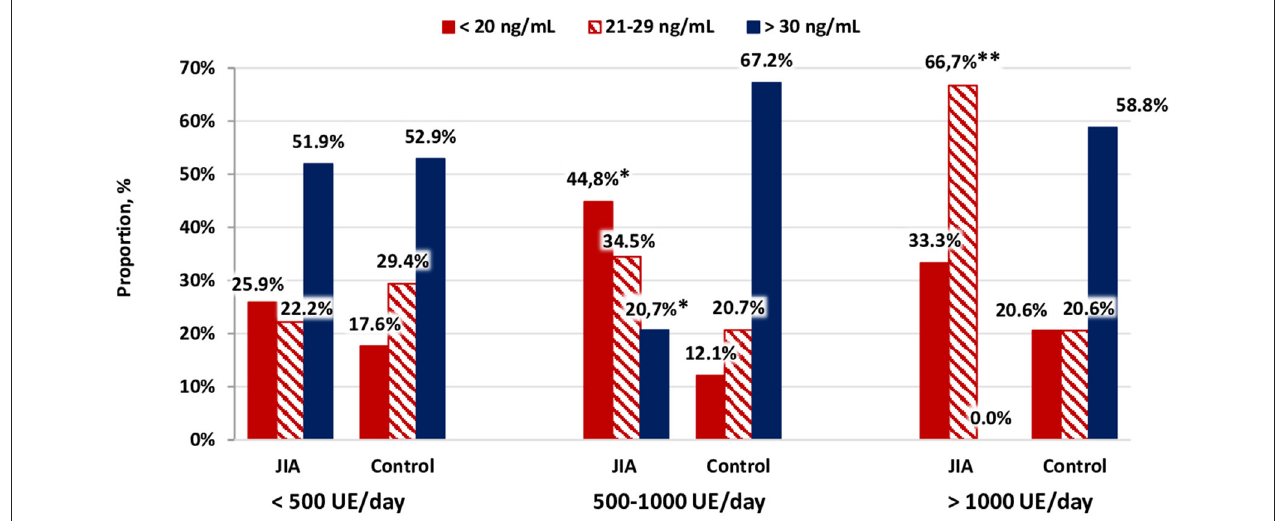
FIGURE 4 | Distribution of vitamin D status as a function of the dose of cholecalciferol supplementation.* p < 0.001, comparison between the JIA and control group, calculated using Pearson’s χ 2. ** p < 0.05, comparison between the JIA and control group, calculated using Fisher’s exact